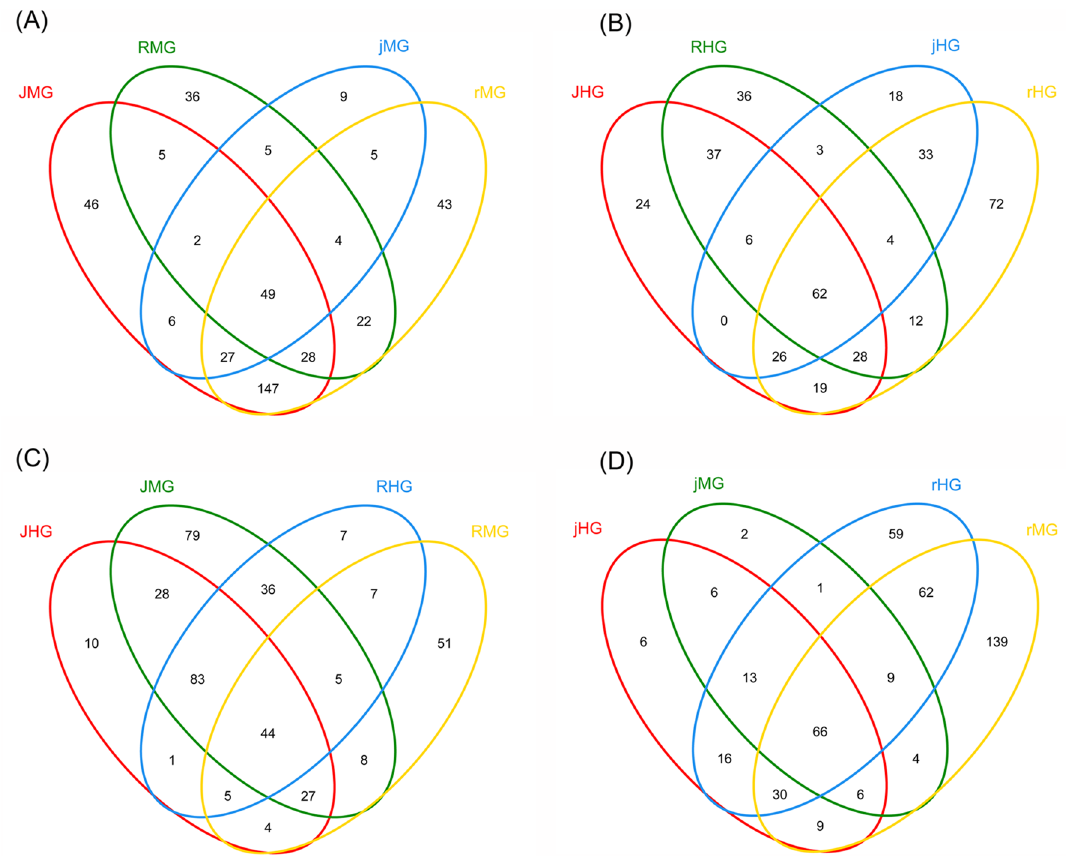
Figure 3. Venn diagram of OTUs from unique species owned by each sample and common species shared by two or more samples. ( A ) Midgut samples of cross-rearing populations and original populations. ( B ) Hindgut samples of cross-rearing populations and original populations. ( C ) Midgut and hindgut samples of original populations. ( D ) Midgut and hindgut samples of cross-rearing populations. JMG midguts of water-oat population feeding on water-oat fruit pulps, RMG midguts of rice population feeding on rice seedlings, jMG midguts of water-oat population feeding on rice seedlings, rMG midguts of rice population feeding on water- oat fruit pulps, JHG hindguts of water-oat population feeding on water-oat fruit pulps, RHG hindguts of rice population feeding on rice seedlings, jHG hindguts of water-oat population feeding on rice seedlings, rHG hindguts of rice population feeding on water-oat fruit